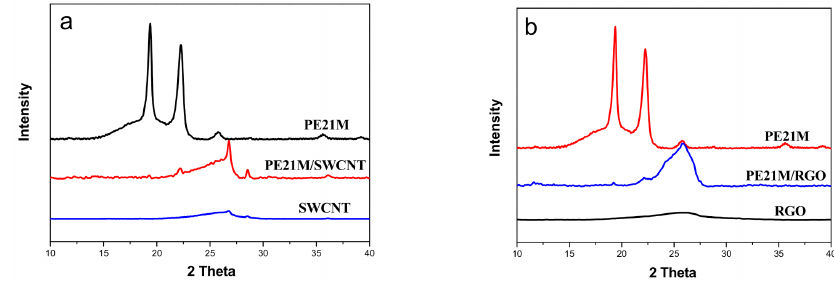
Figure 8. XRD diffractograms of PE21M, nanofillers, and PE21M/nanofiller composites. ( a ) PE21M/SWCNT nanocomposites, and ( b ) PE21M/RGO